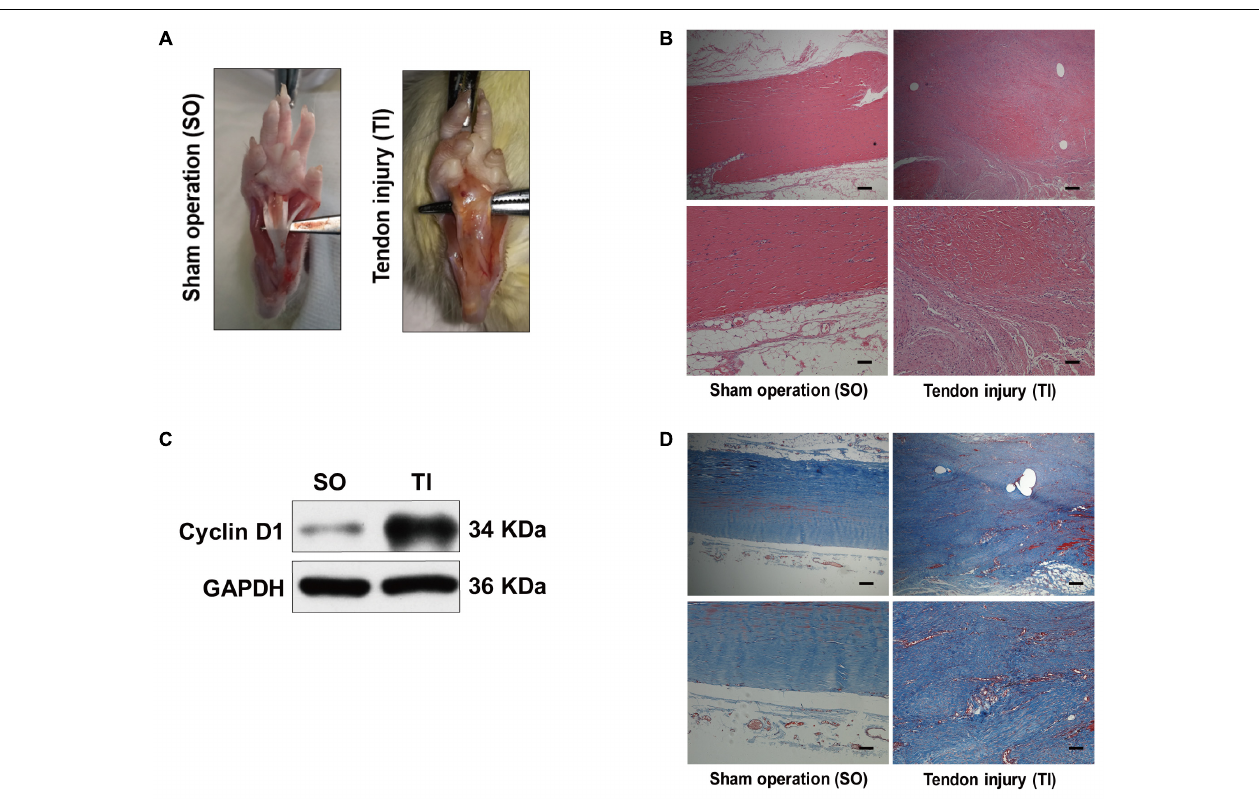
FIGURE 1 | Peritendinous adhesion formation after tendon injury. (A) Representative images of macroscopic observation of deep flexor tendon of the plantar at 21 days after sham operation (SO) or tendon injury (TI). (B) Representative images of H&E staining of peritendinous tissues. Scale bar (upper): 250 µ m. Scale bar (lower): 100 µ m. (C) Representative images of western blot analysis of Cyclin D1 expression in SO and TI rats. (D) Representative images of masson staining of peritendinous tissues at 21 days after SO or TI rats. Scale bar (upper): 250 µ m. Scale bar (lower): 100 µ m. n = 5 in each